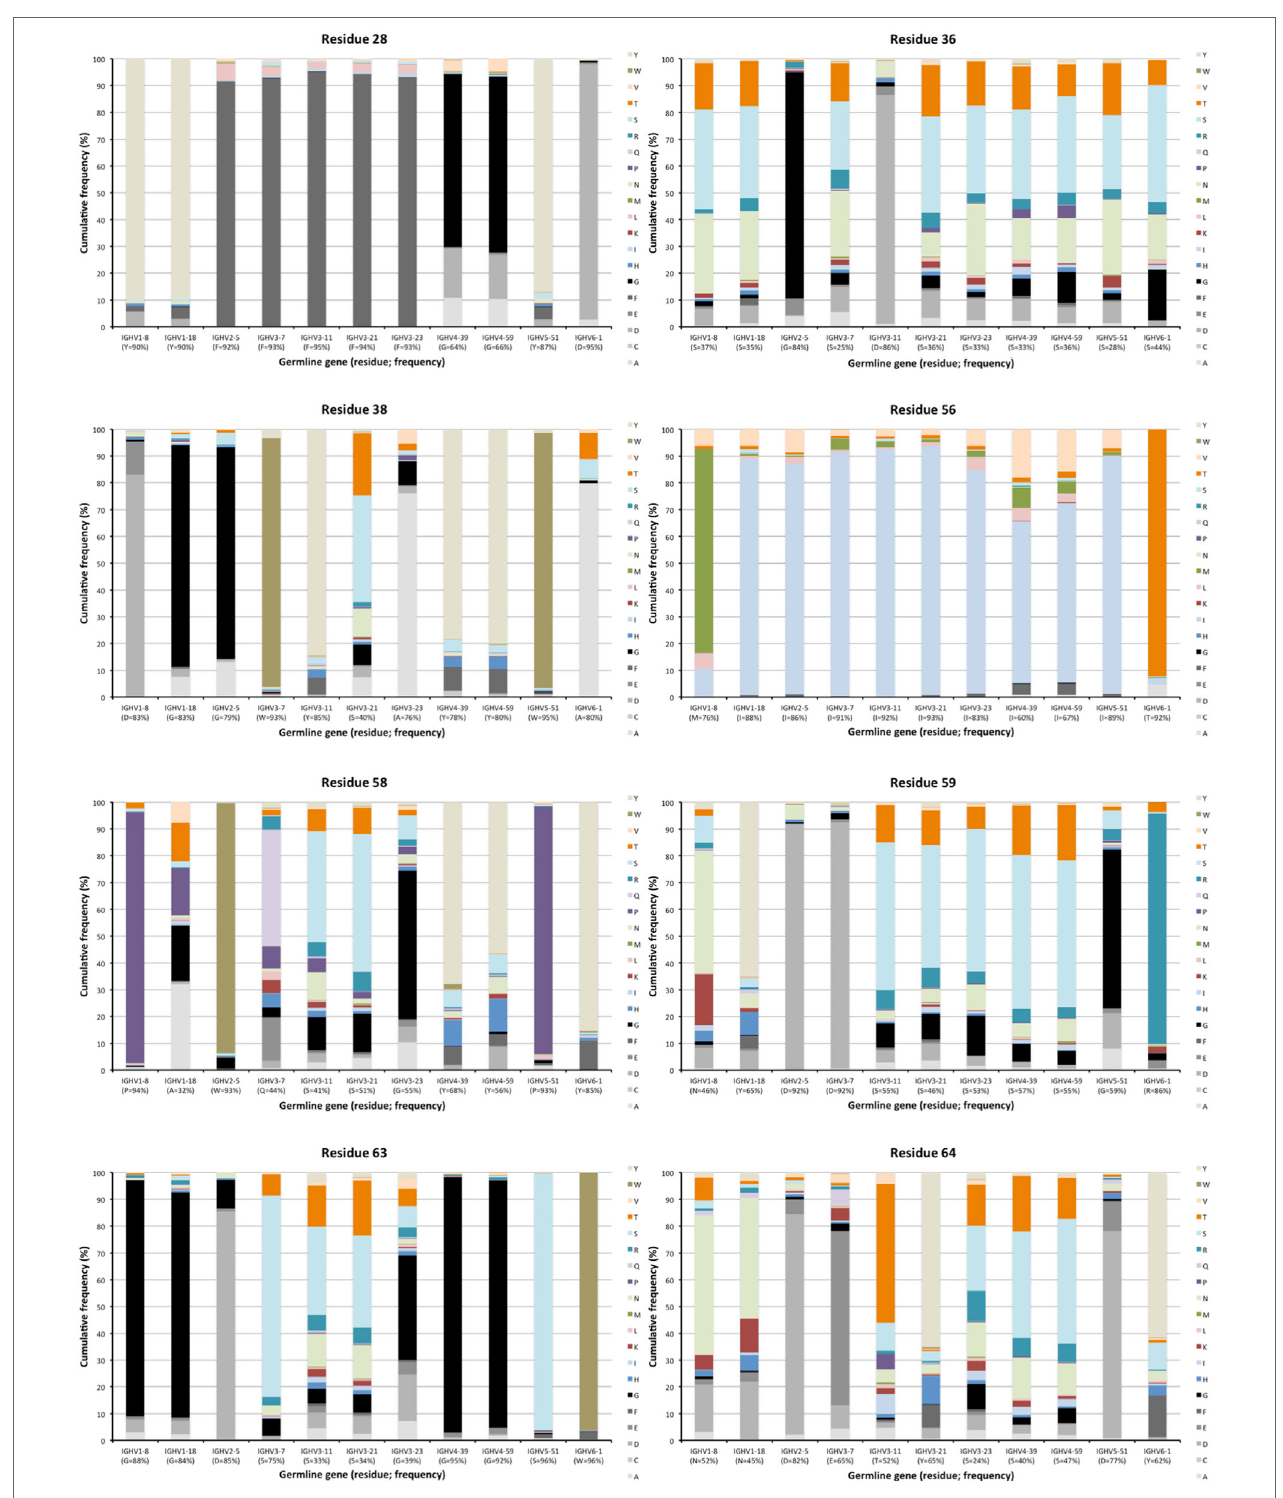
FigUre 4 | Examples of differences in diversification of residues in complementarity determining region (CDR) encoded by transcripts of different germline gene origins. Residues shown include positions 28, 36, and 38 of CDRH1, and positions 56, 58, 59, 63, and 64 of CDRH2 of IgG. The germline-encoded residues and their frequencies in IgG-encoding transcripts are shown at the bottom of the graph. Substitutions are introduced in 5–36% (residue 28), 14–75% (residue 36), 5–60% (residue 38), 7–40% (residue 56), 6–68% (residue 58), 8–54% (residue 59), 4–67% (residue 63), and 18–76% (residue 64) of the transcripts depending on their different germline gene